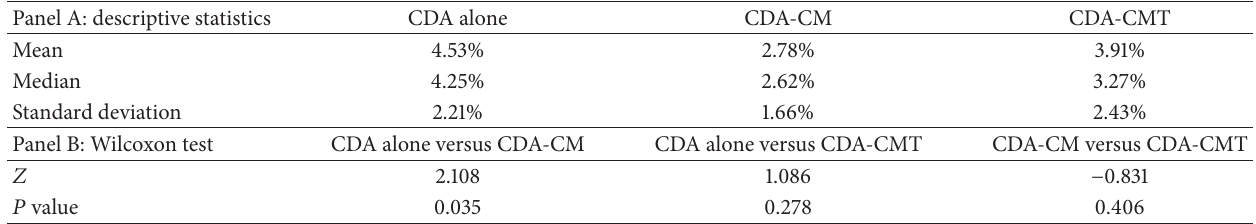
Table 6: Descriptive statistics of period spreads and results of Wilcoxon rank sum tests on average series spreads between the stand-alone CDA and the CDA of the complement